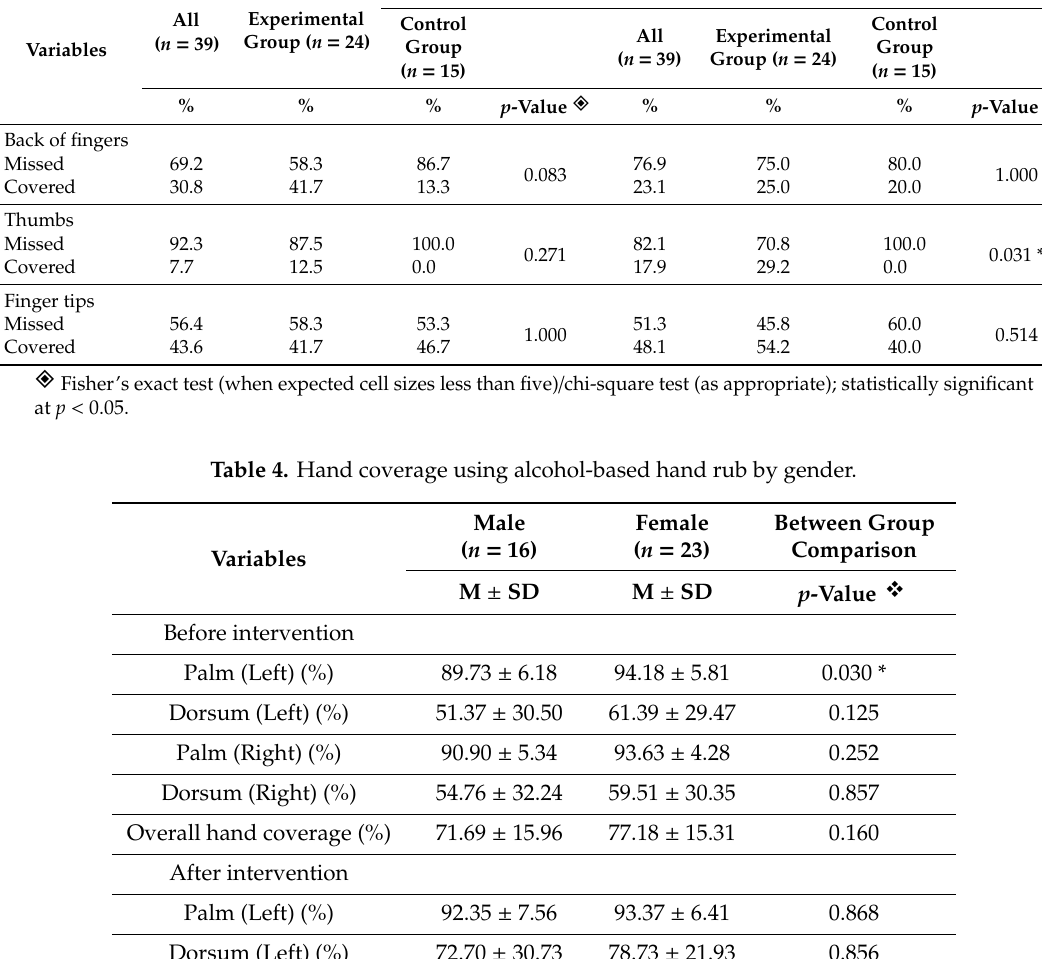
Table 2. Within-group and between-group comparisons of hand coverage (%) using hand sanitizer.